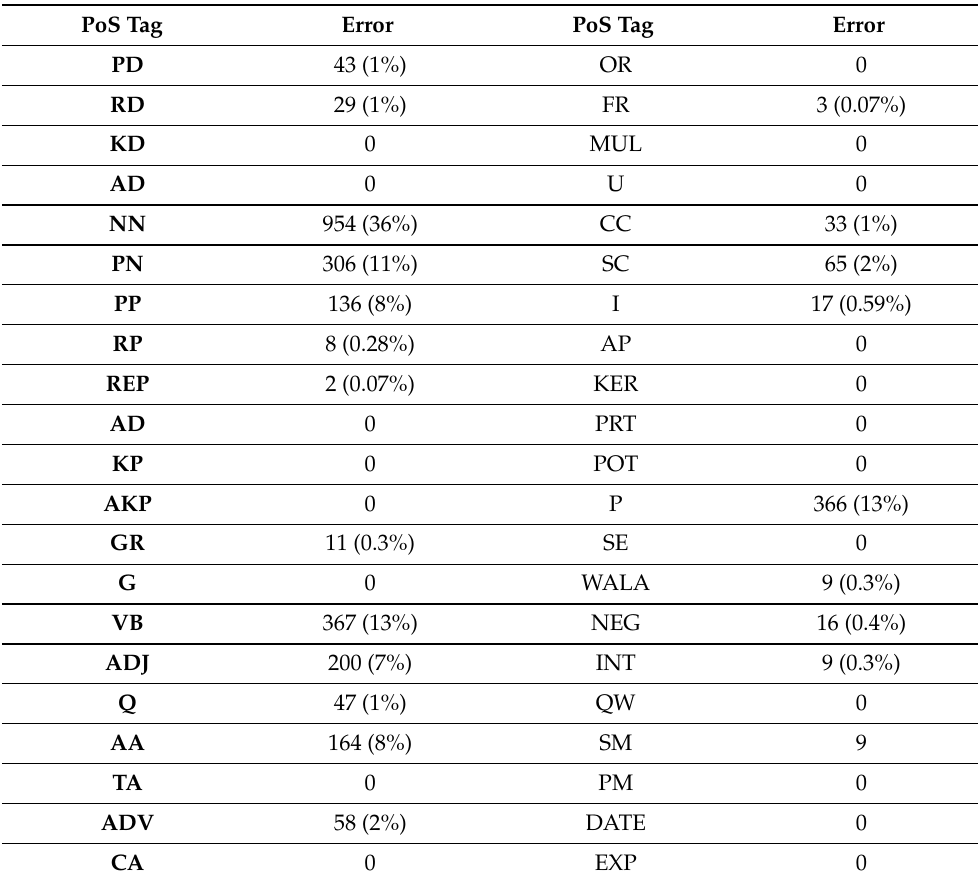
Table 8. Error analysis of with-PoS-DLA approach with respect to the PoS